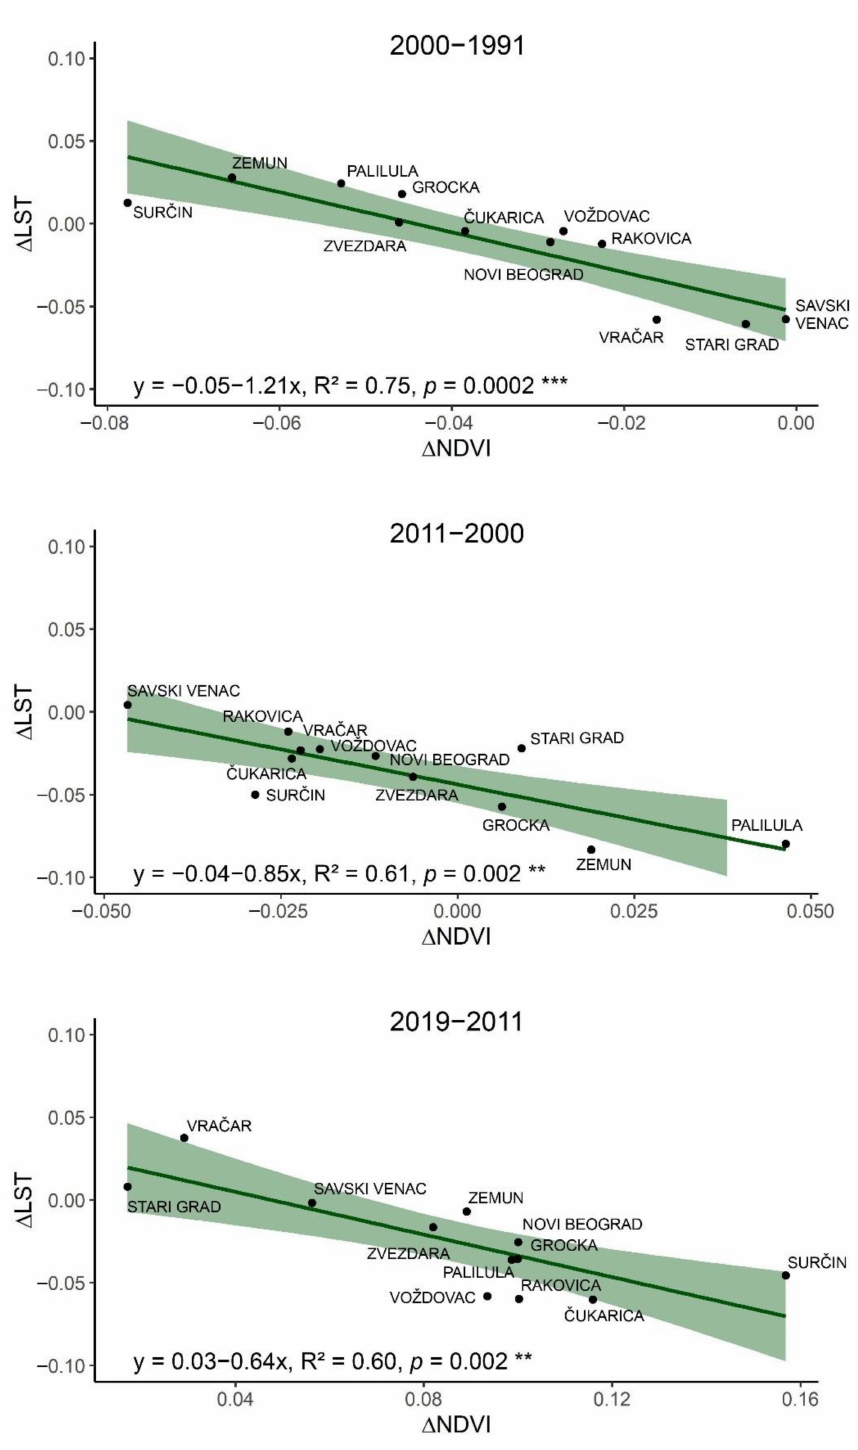
Figure 9. Relationship between the change in the NDVI and the change in the LST in the last three decades. Significance levels: * p < 0.05, ** p < 0.01, *** p < 0.001. Between change in the NDWI and change in the LST, a significant negative relationship was recorded in the second (2011–2000) and the third decade (2019–2011) (R 2 = 0.52 and R 2 = 0.74, respectively, Figure 10). The municipalities with the largest decrease (or the smallest increase in the third decade) in the NDWI had the largest increase in the